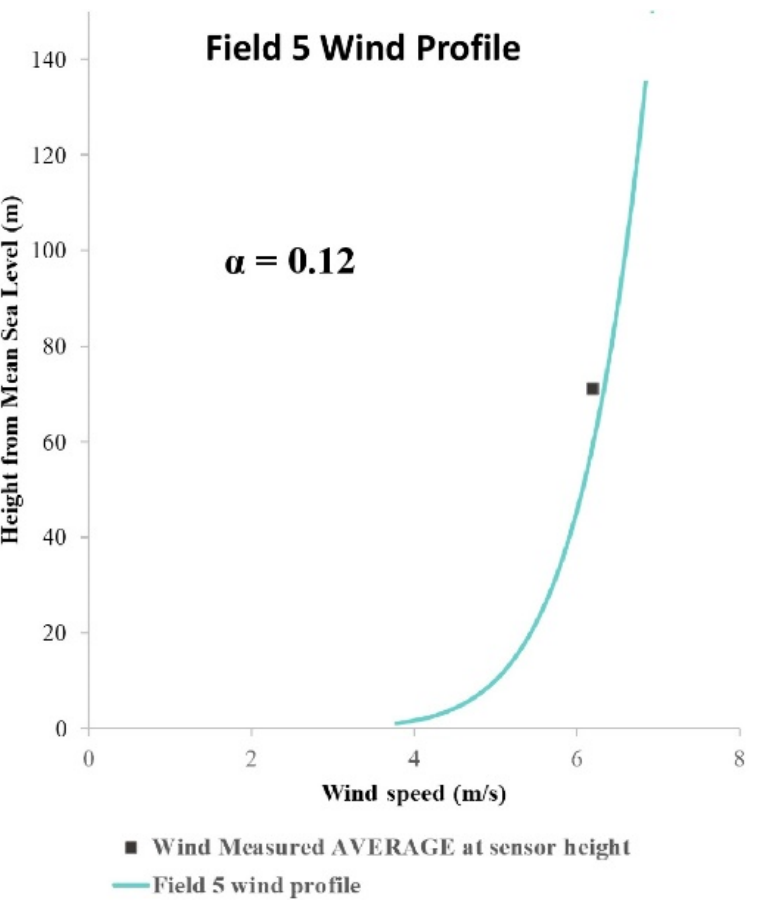
Figure 5. Field 5 wind profile.